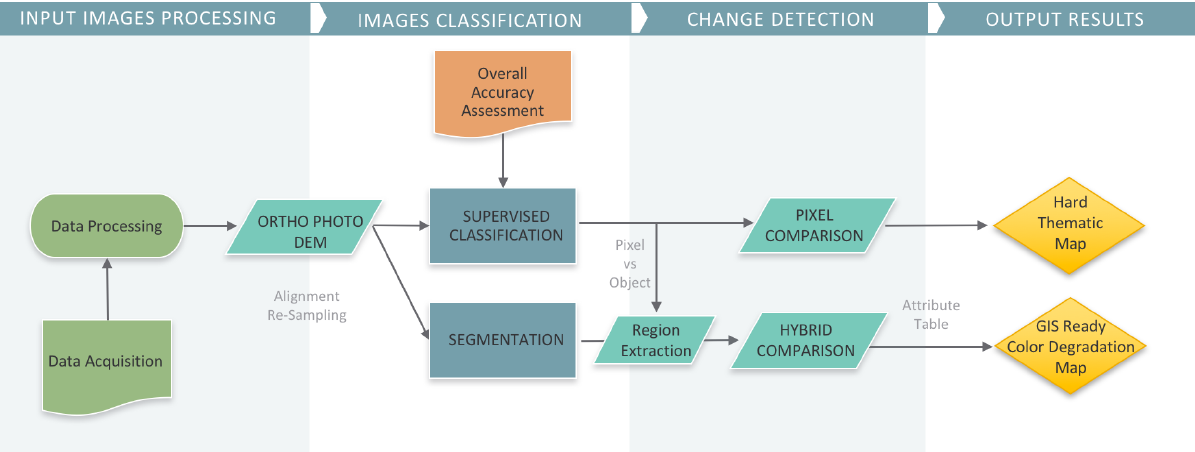
Figure 2. The image represents the orto-rectified image of the bas-relieve using the set of images of 2006. The dashed blue line depicts the portion of the entire surface that has been used for the experiments.